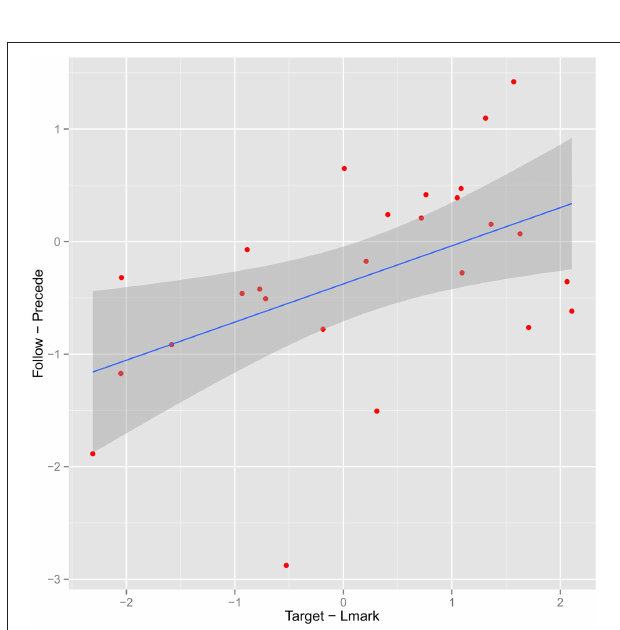
FIGURE 4 | Plot of median (target-first-landmark-first) reaction time as a function of median (target-landmark) reaction time. Each point represents a stimulus; fitted regression line uses linear model.